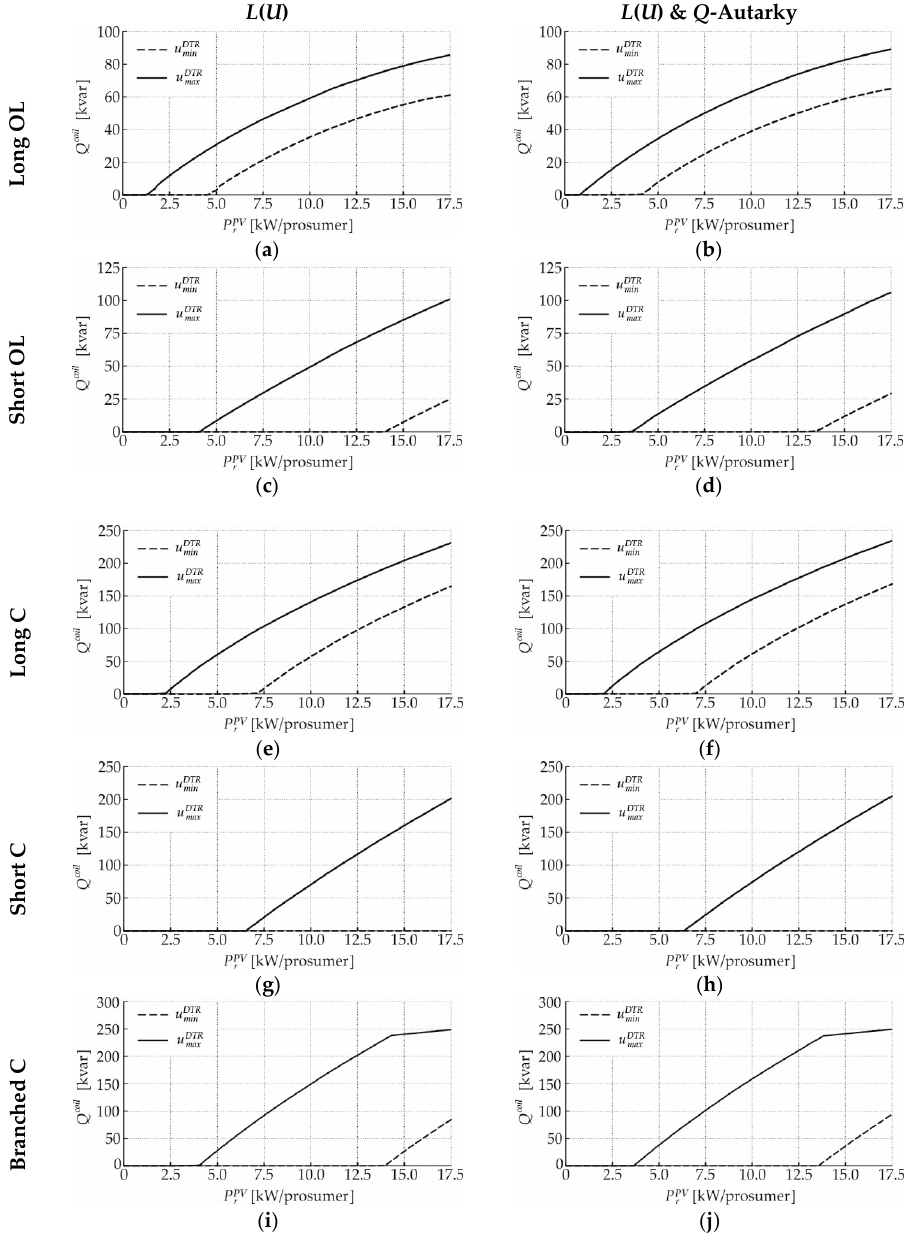
Figure A1. Reactive power consumption of the inductive device in case of L ( U ) and its combination with Q -Autarkic prosumers for minimal and maximal DTR primary voltage and different test-feeders: ( a , b ) Long OL; ( c , d ) Short OL; ( e , f ) Long C; ( g , h ) Short C; ( i , j ) Branched C.